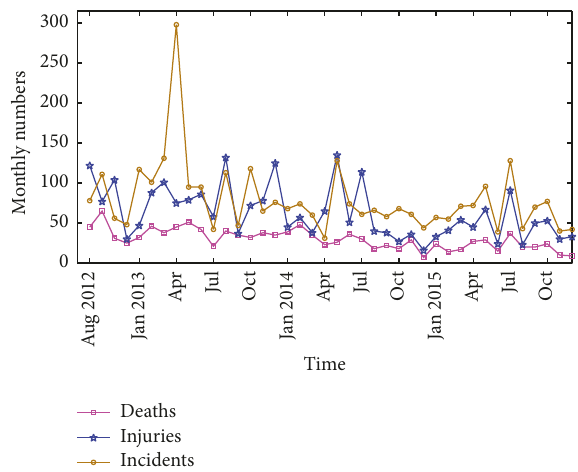
Figure 2: Monthly number of deaths, injuries, and incidents for unrest in the four southern provinces of